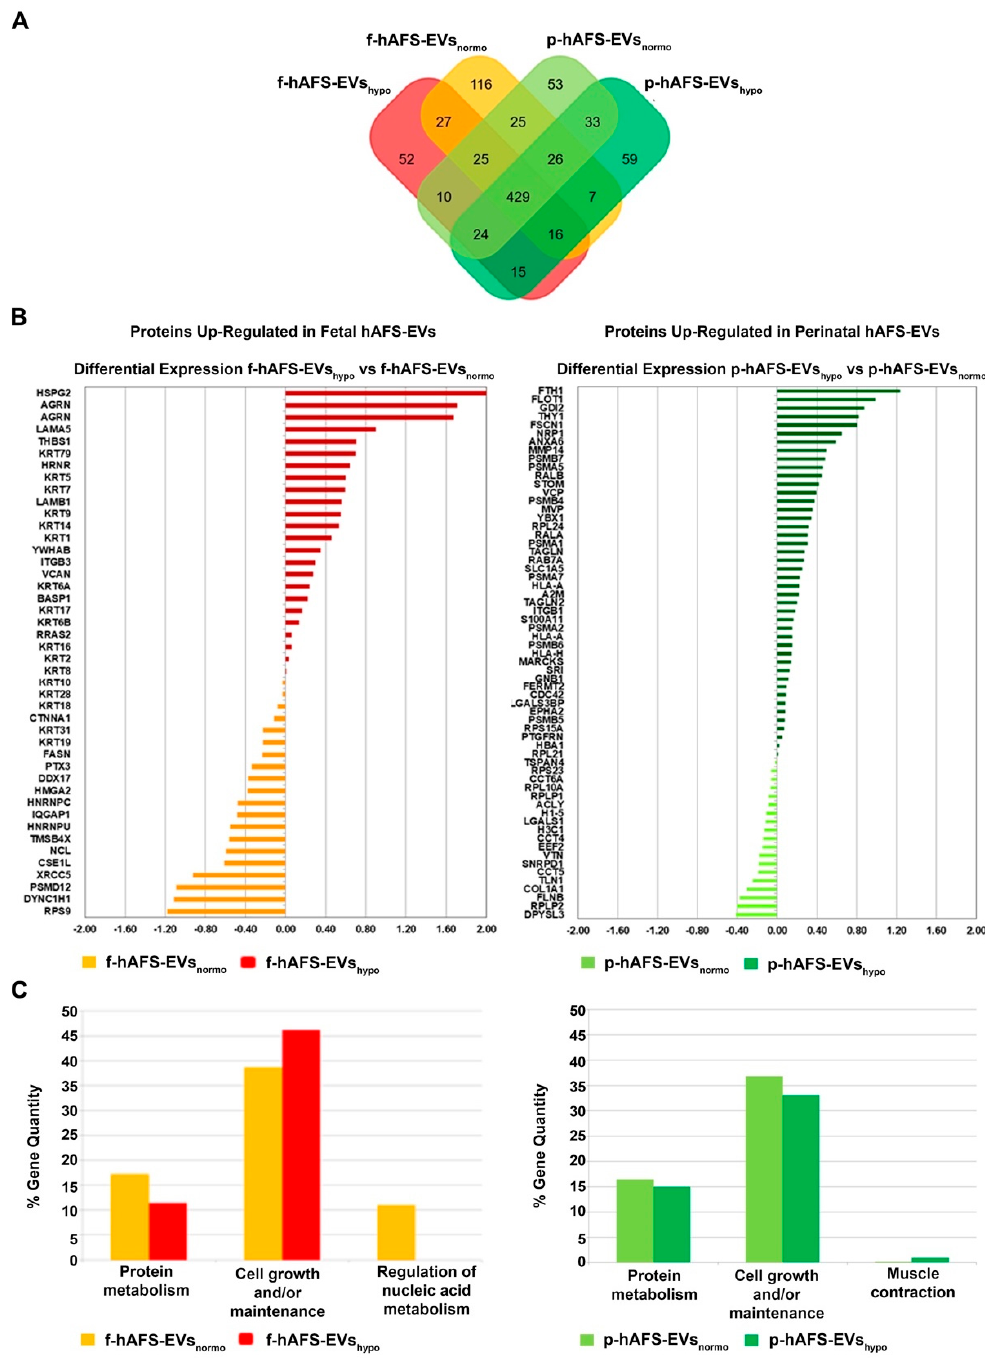
Figure 6 . Comparative proteomics analysis of fetal- and perinatal hAFS-EVs. ( A ) Venn diagram illustrating the distribution of proteins identified with a frequency of at least 2 within f-hAFS-EVs normo (dark yellow), f-hAFS-EVs hypo (red), p-hAFS-EVs normo (light green) and p-hAFS-EVs hypo (dark green). ( B ) Differentially expressed proteins identified in fetal hAFS-EVs (left panel) and perinatal hAFS-EVs (right panel) by label-free quantification with MAProMa software. Left panel: histogram reporting the differential expression of proteins found upregulated between normoxic control (dark yellow bars and negative DAve values) and hypoxic preconditioning (red bars and positive DAve values) of f-hAFS-EVs over p-hAFS-EVs. Right panel: histogram reporting the differential expression of proteins found upregulated between control normoxic (light green bars and negative DAve values) and hypoxic preconditioning (dark green bars and positive DAve values) of p-hAFS-EVs over f-hAFS-EVs. Proteins with DAve (ratio of protein expression) ≥ |0.4| and a DCI (confidence of differential expression) ≥ |5| passed the filters and were considered differentially expressed; see Table S3 for the complete list and detailed